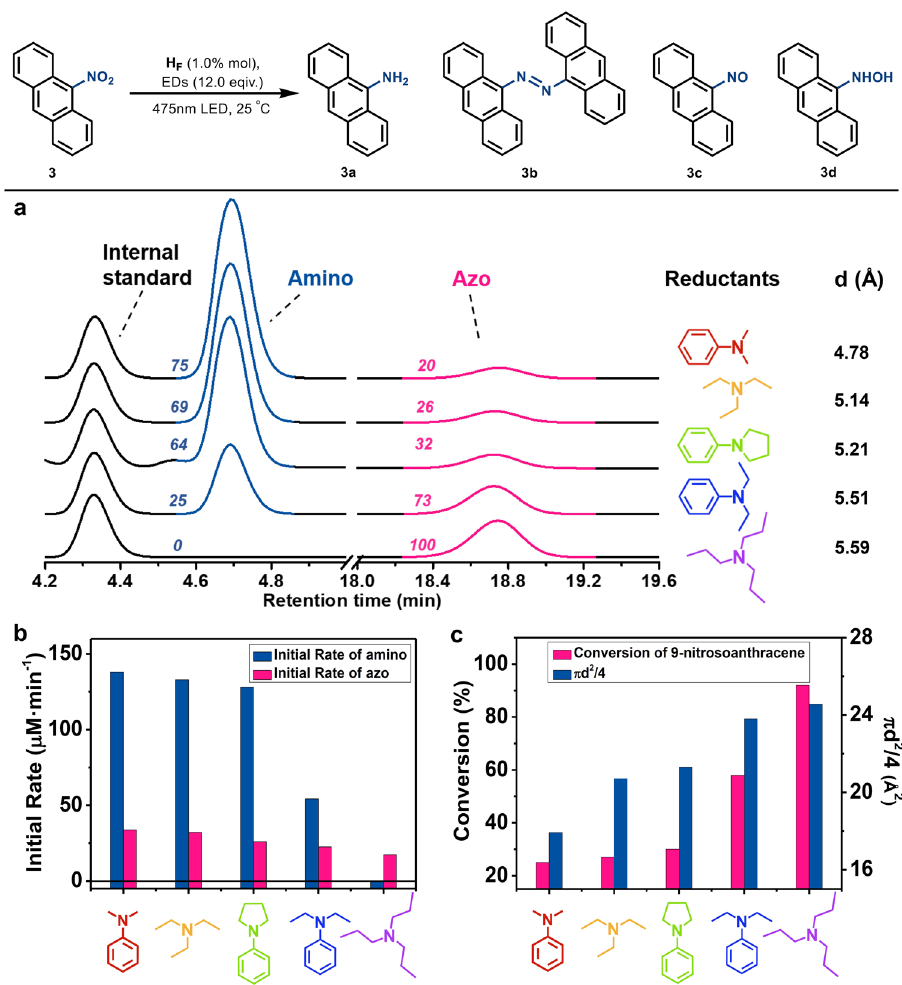
Fig. 4 Photoreduction of 9-nitroanthracene with different electron donors. a The conversion of azo and amino products from the reduction of 9-nitroanthracene with various electron donors under standard conditions. b The initial conversion rates of the azo and amino product from the reduction of 9-nitroanthracene with various electron donors under standard conditions. c The conversion of 9-nitrosoanthracene from the reduction of 9-nitroanthracene with various electron donors as a function of the estimated diameter of substrates (shown as π d 2 /4) of the electron